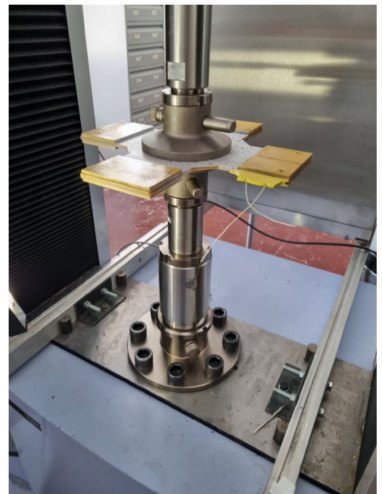
Figure 7. The scheme of loading.